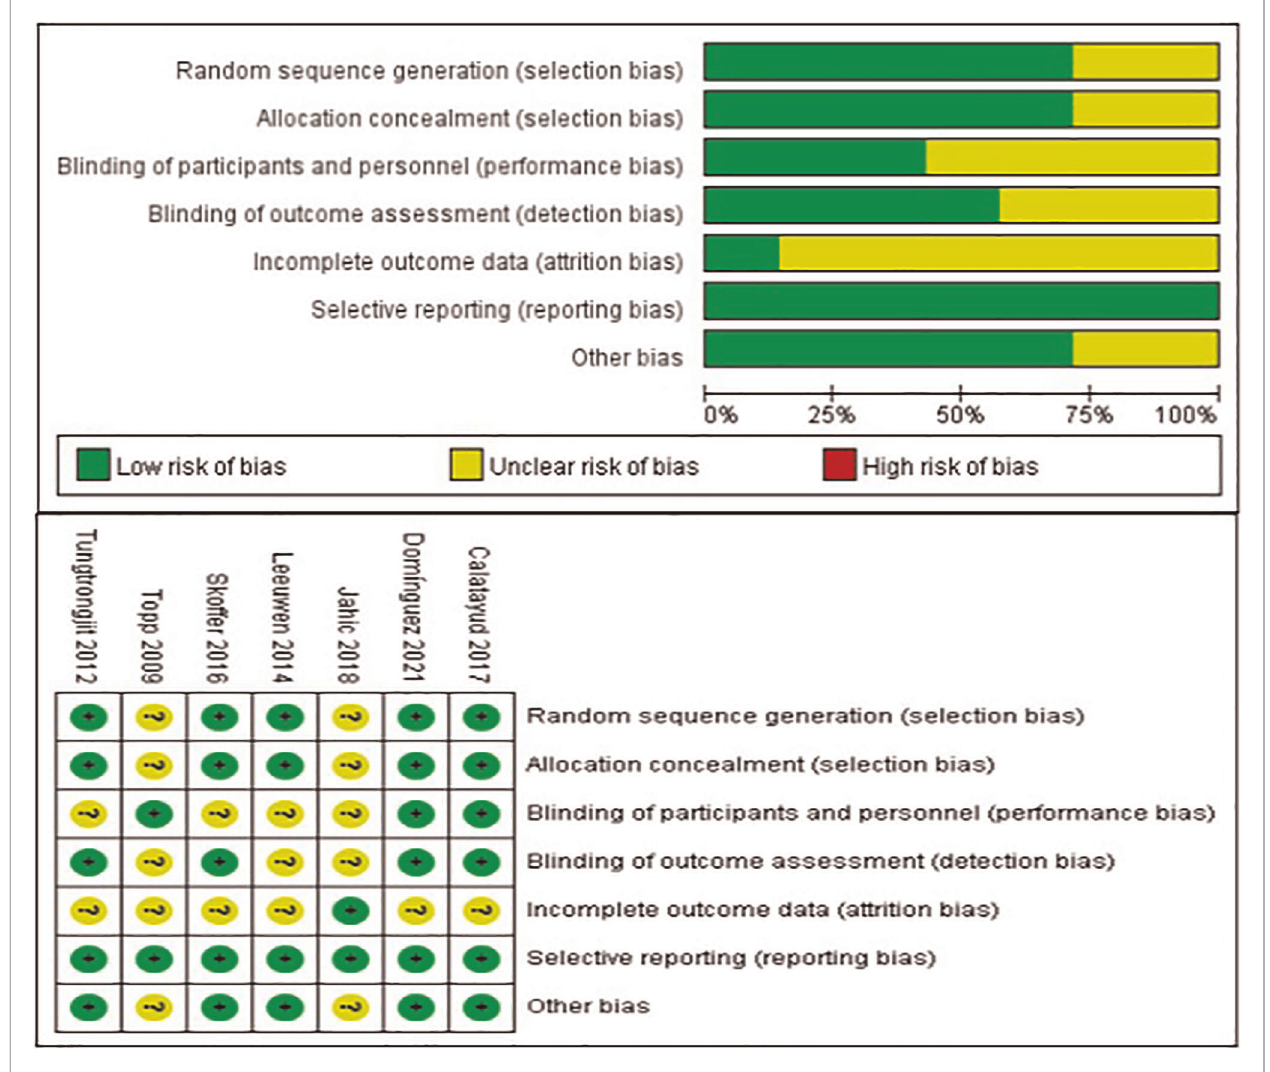
FIGURE 2 | Risk of bias